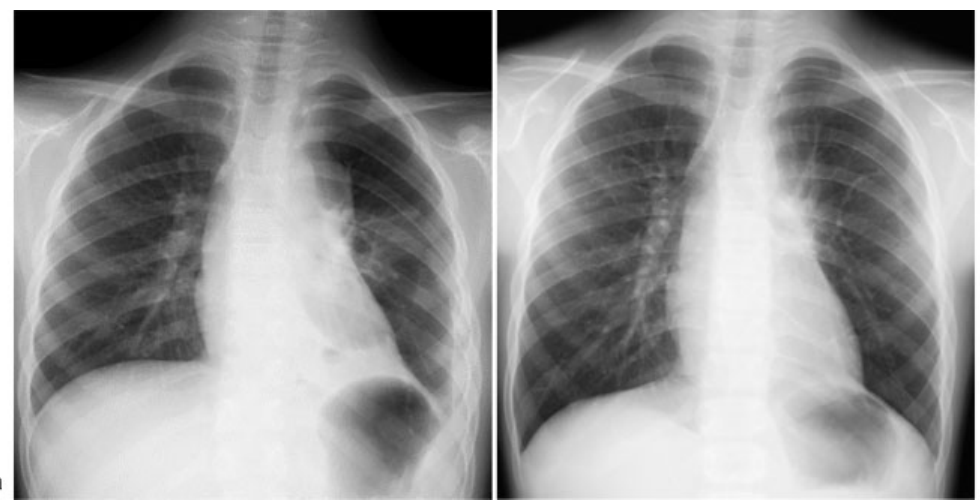
Fig. 5 Postoperative chest radiograph ( a ) 5 days after surgery and ( b ) 4 months after